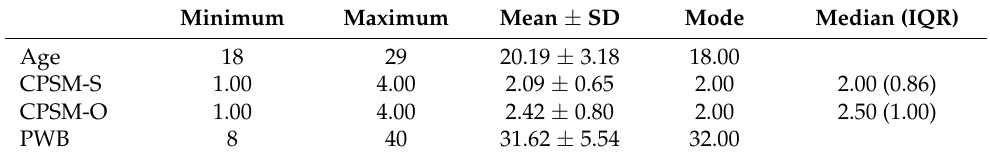
Table 1. The descriptive statistics of continuous variables age, CPSM-S, CPSM-O, and PWB ( n = 523). Minimum Maximum Mean ± SD Mode Median (IQR) Age 18 29 20.19 ± 3.18 18.00 CPSM-S 1.00 4.00 2.09 ± 0.65 2.00 2.00 (0.86) CPSM-O 1.00 4.00 2.42 ± 0.80 2.00 2.50 (1.00) PWB 8 40 31.62 ± 5.54